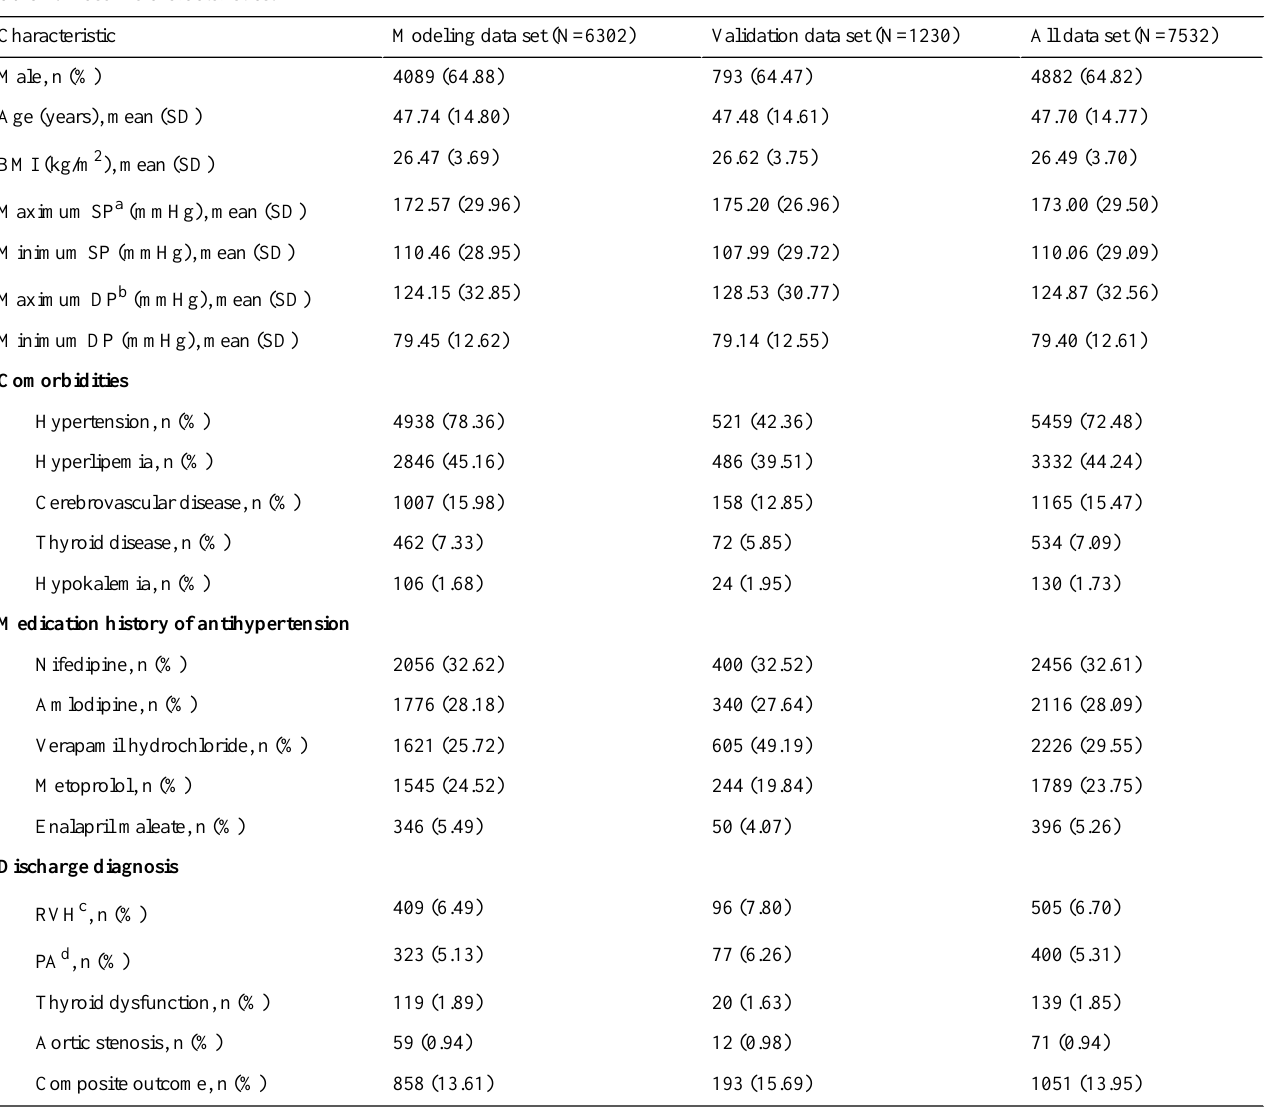
Table 1. Baseline